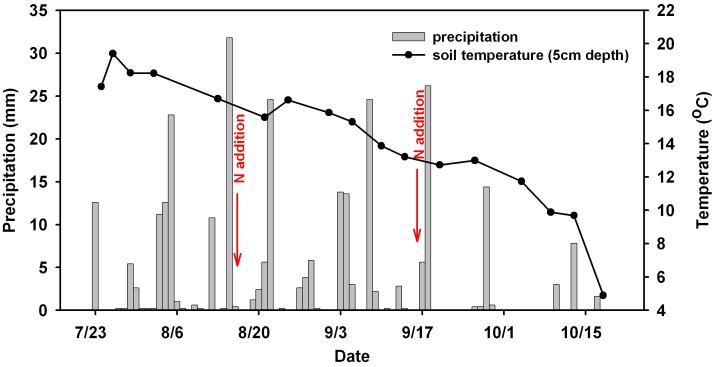
Variations of precipitation and soil temperature (5 cm depth) in the study area during the sampling periods.